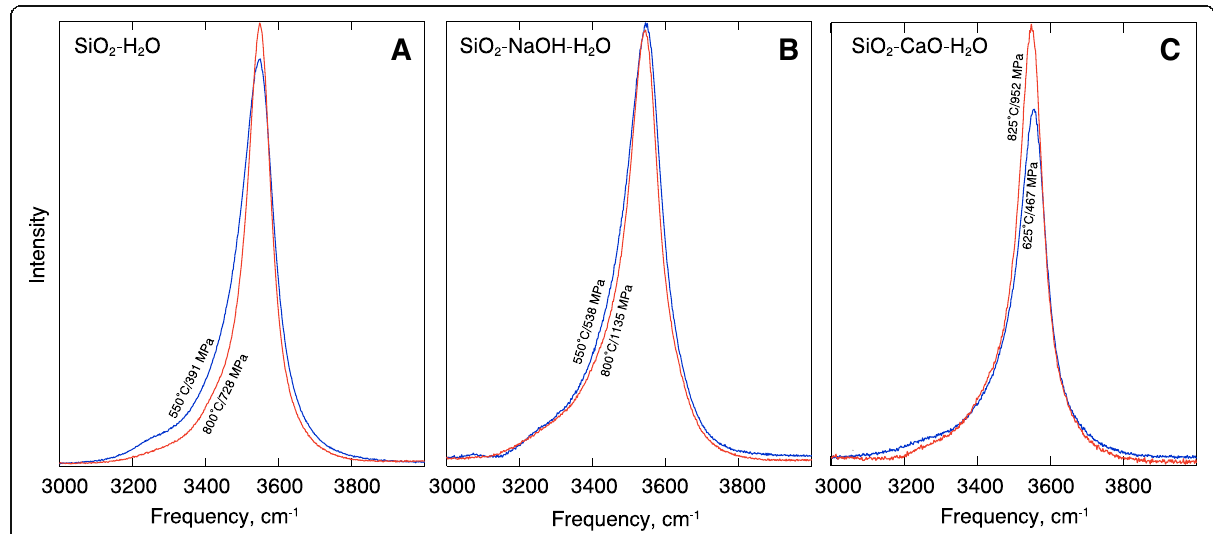
Fig. 3 Examples of high-frequency portion of Raman spectra in the systems SiO 2 – H 2 O ( a ), SiO 2 – NaOH – H 2 O ( b ), and SiO 2 – CaO – H 2 O ( c ) at pressure and temperature conditions as indicated on the individual spectra